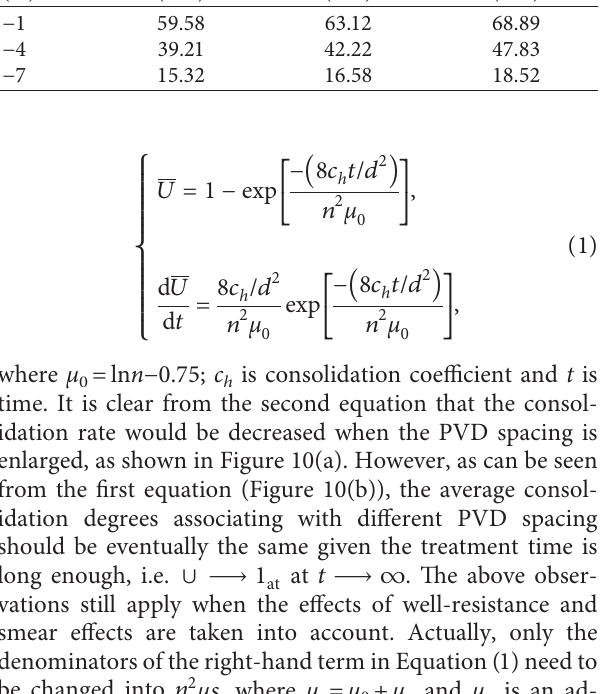
Table 2: Final PWP dissipations during vacuum preloading period.